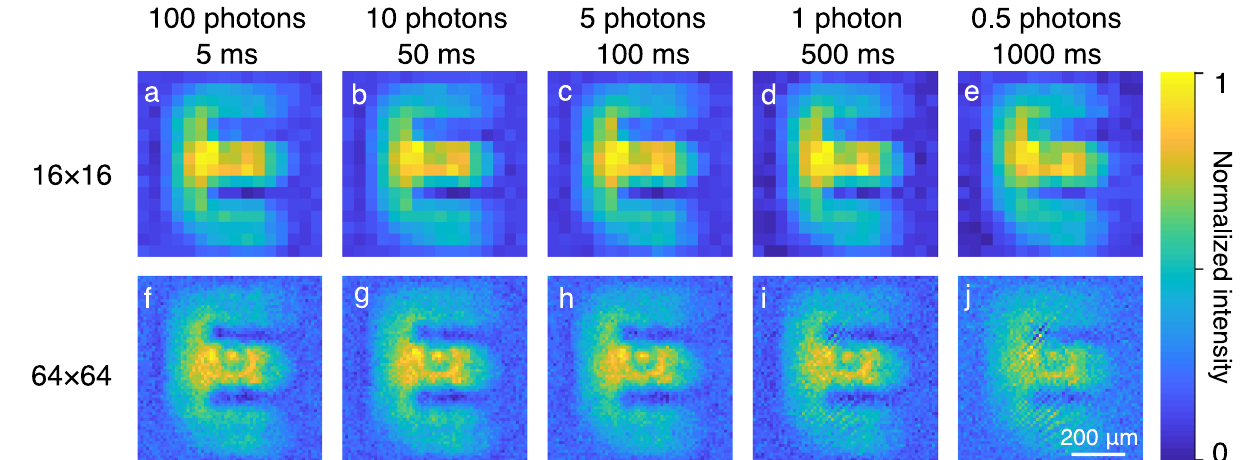
fl uxes from 100 to 0.5 photons/pulse, under increased accumulation time from 5 ms to 1 s for each masking pattern. The top ( a – e ) and bottom ( f – j ) panels corre- spond to the number of pixels of 16×16 and 64×64, respectively.